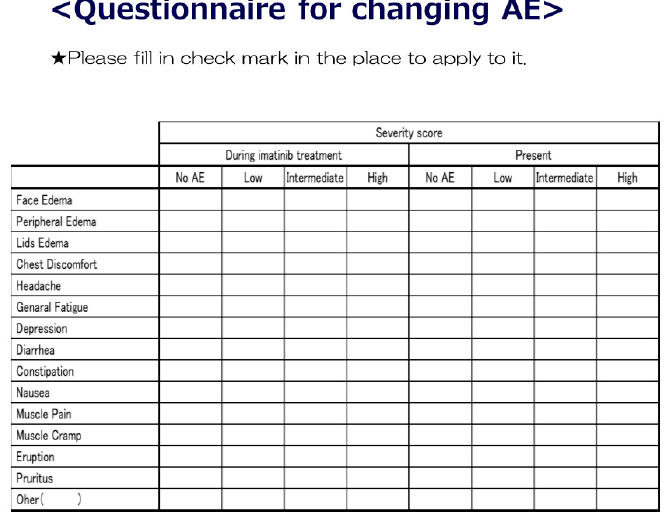
Figure 1. An interview form for adverse drug events (ADEs) was prepared for all patients. Patient- reported adverse events (ADEs) were assessed during the interview using a structured questionnaire.